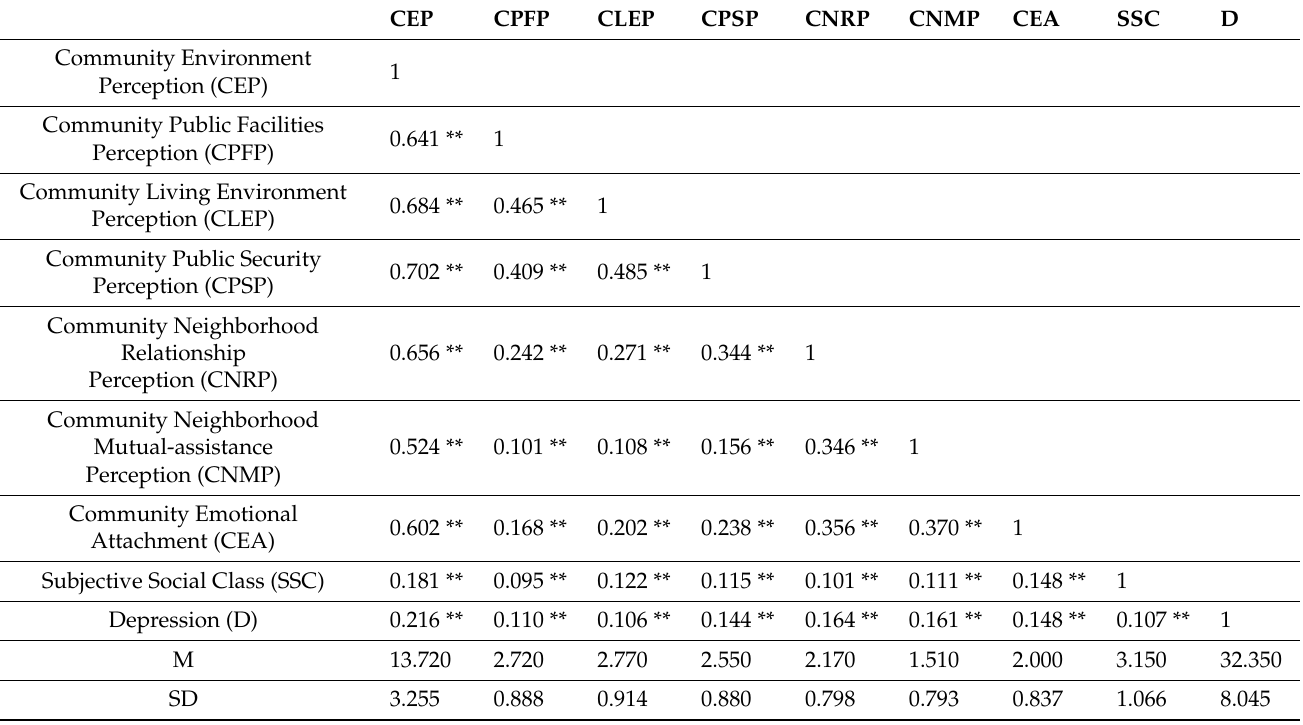
Table 2. Descriptive statistics and correlation coefficients for the study